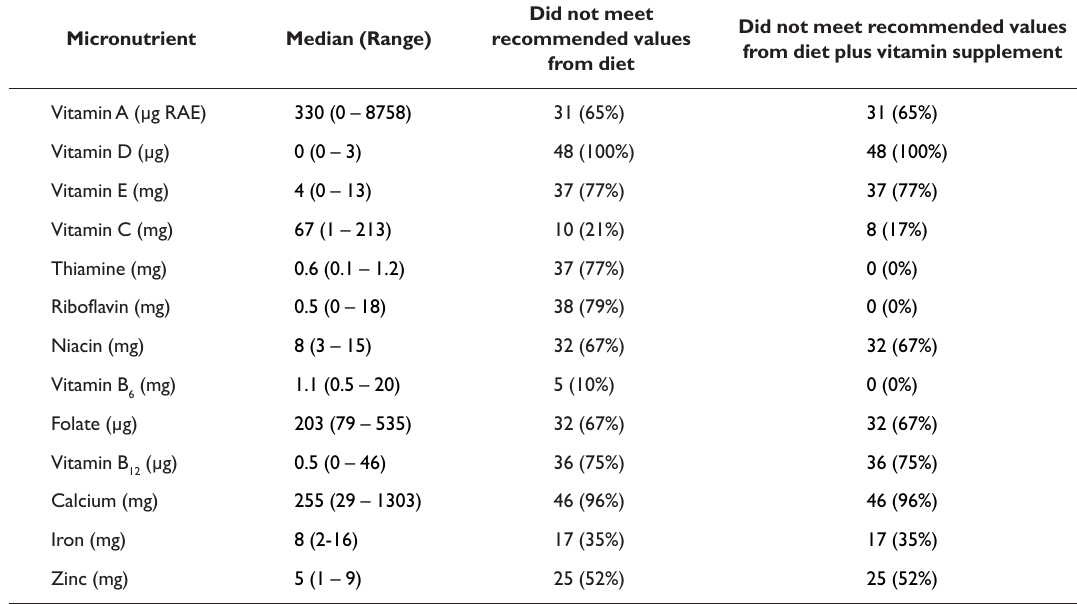
Table 2 Micronutrient intakes of the study participants compared to World Health Organization recommendations